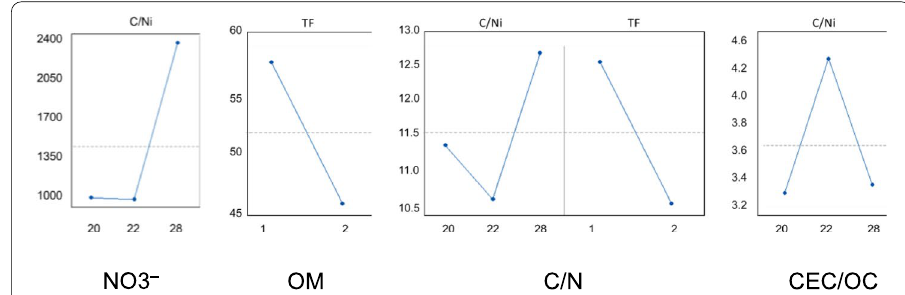
Fig. 15 Compilation of significative effects of C/Ni and TF factors on final compost parameters